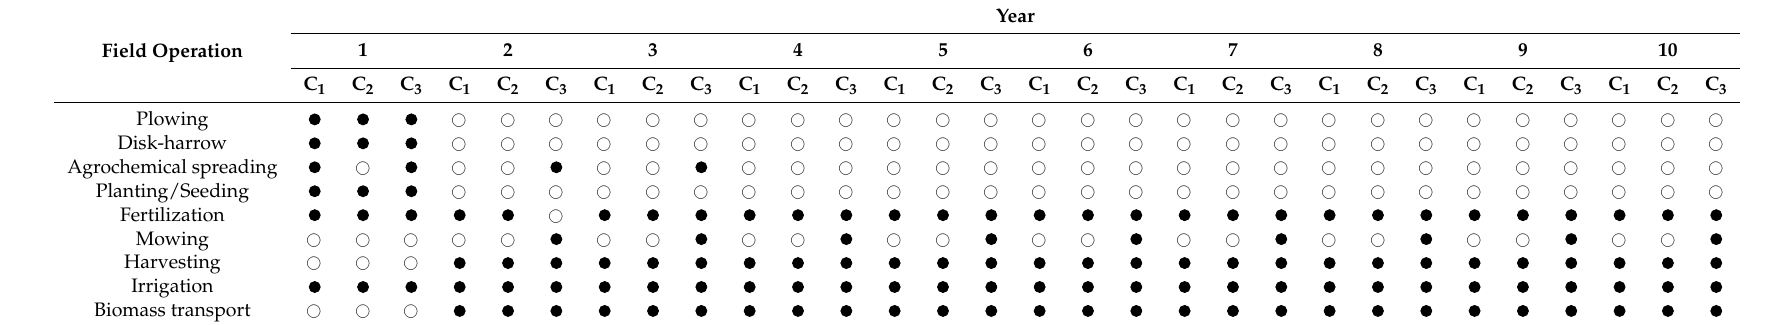
Table 1. Field operations of the three crops for a ten-year period.